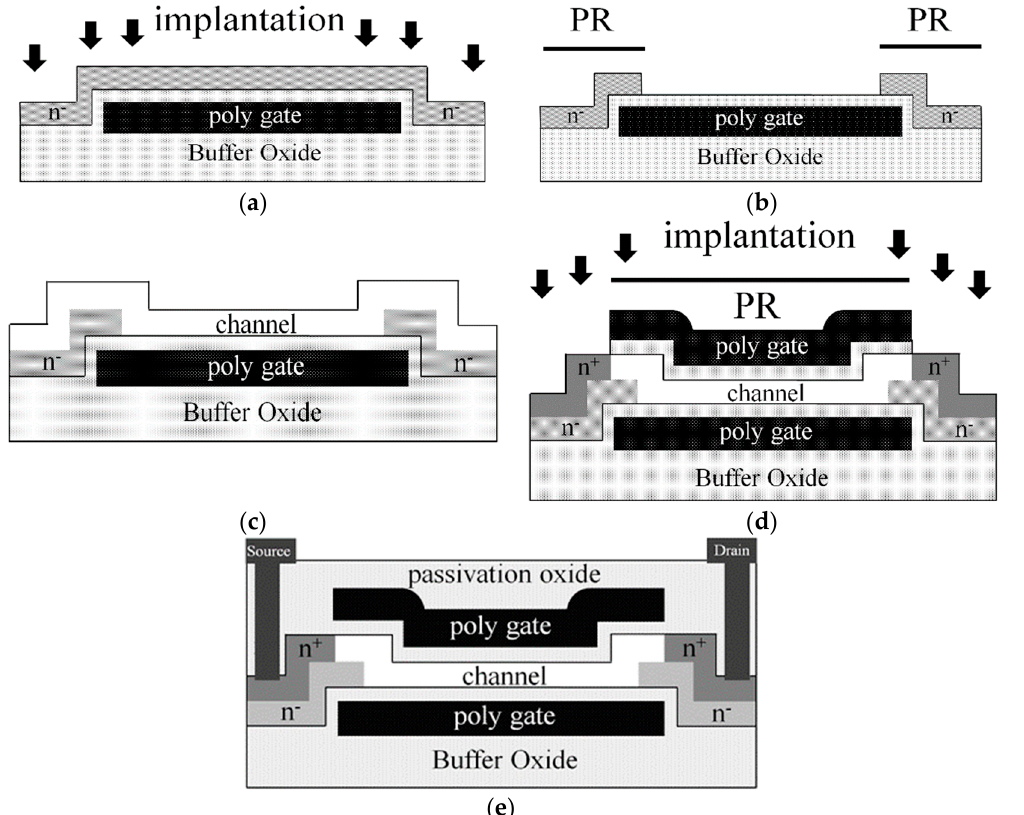
Figure 2. Main fabrication processes of the double-gate two-step source/drain Poly-Si TFT: ( a ) Making a bottom gate and implanting the GOLDD layer, ( b ) forming the partial GOLDD region, ( c ) depositing a channel, ( d ) defining the top gate and forming the drain/source areas, and ( e ) contact opening and metal pads forming.